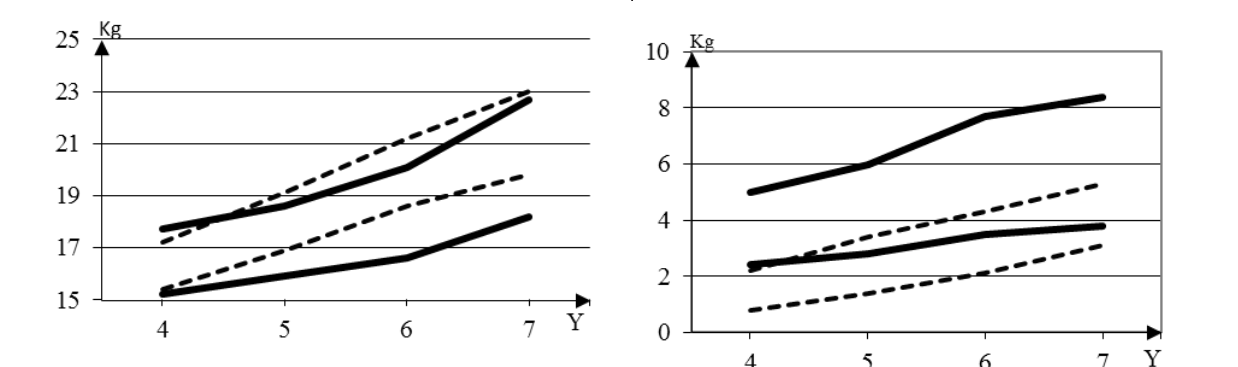
Fig. 7. Right hand dynamometry (P, Kg) from Y (Y, years)